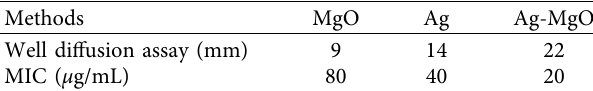
Figure 7: Antibacterial activity of biosynthesized Ag, MgO, and Ag-MgO against E. coli . Table 1: Antibacterial activity.